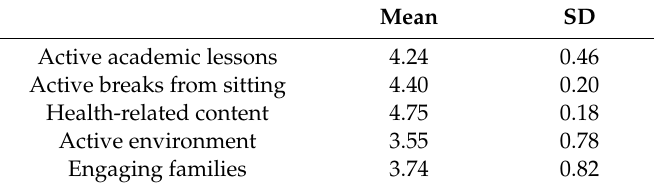
Table 3. Summary statistics of lecturer adherence checklist responses by